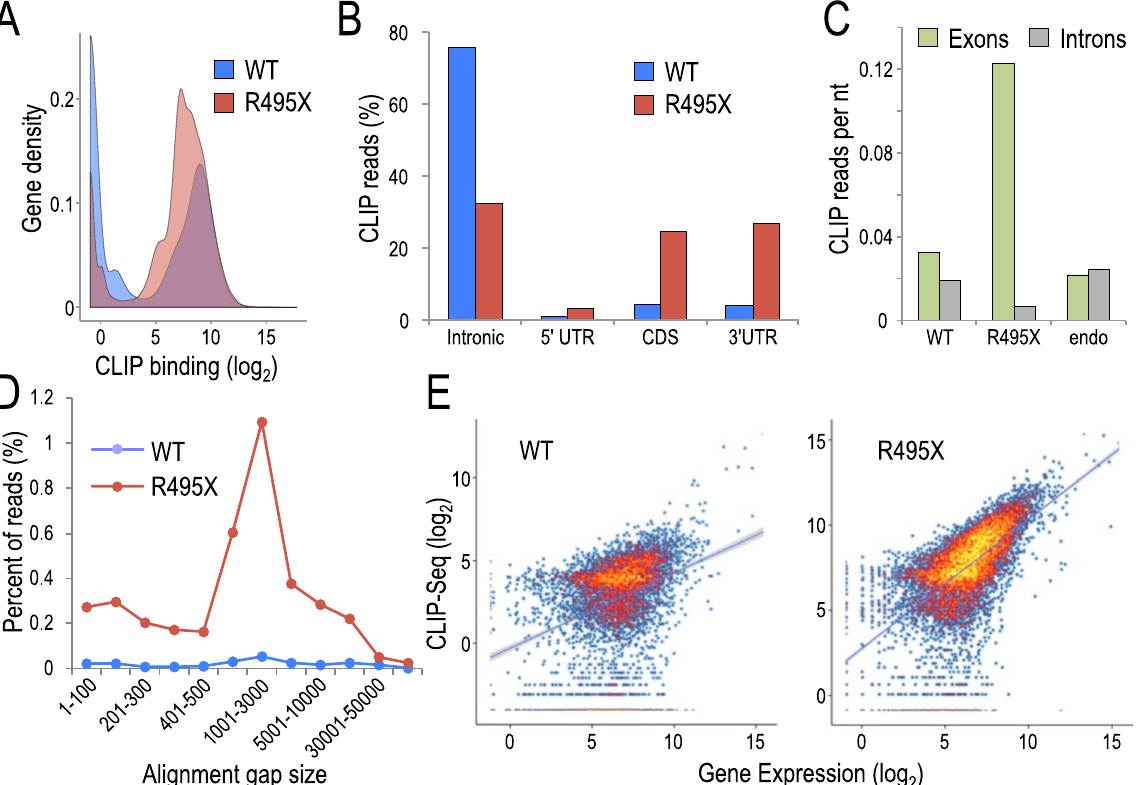
Figure 2. Identification of RNA binding property of R495X compared to WT. ( A ) Gene density plot of CLIP binding for WT (blue) and R495X (red). ( B ) Distribution of CLIP-Seq reads in introns, 5 ′ UTR, coding sequence (CDS) and 3 ′ UTR for WT (blue) and R495X (red). ( C ) Distribution of CLIP-Seq reads in exons (green) and introns (grey) normalized by the total length of these elements for WT, R495X and endogenous FUS (endo). ( D ). Alignment gap size distribution of CLIP-Seq reads for WT (blue) and R495X (red) reads. Only alignment gaps overlapping annotated introns are used. ( E ) Scatter plot for FUS binding versus gene expression levels for WT (left) and R495X (right). Color indicates gene density with yellow and blue indicating higher and lower values